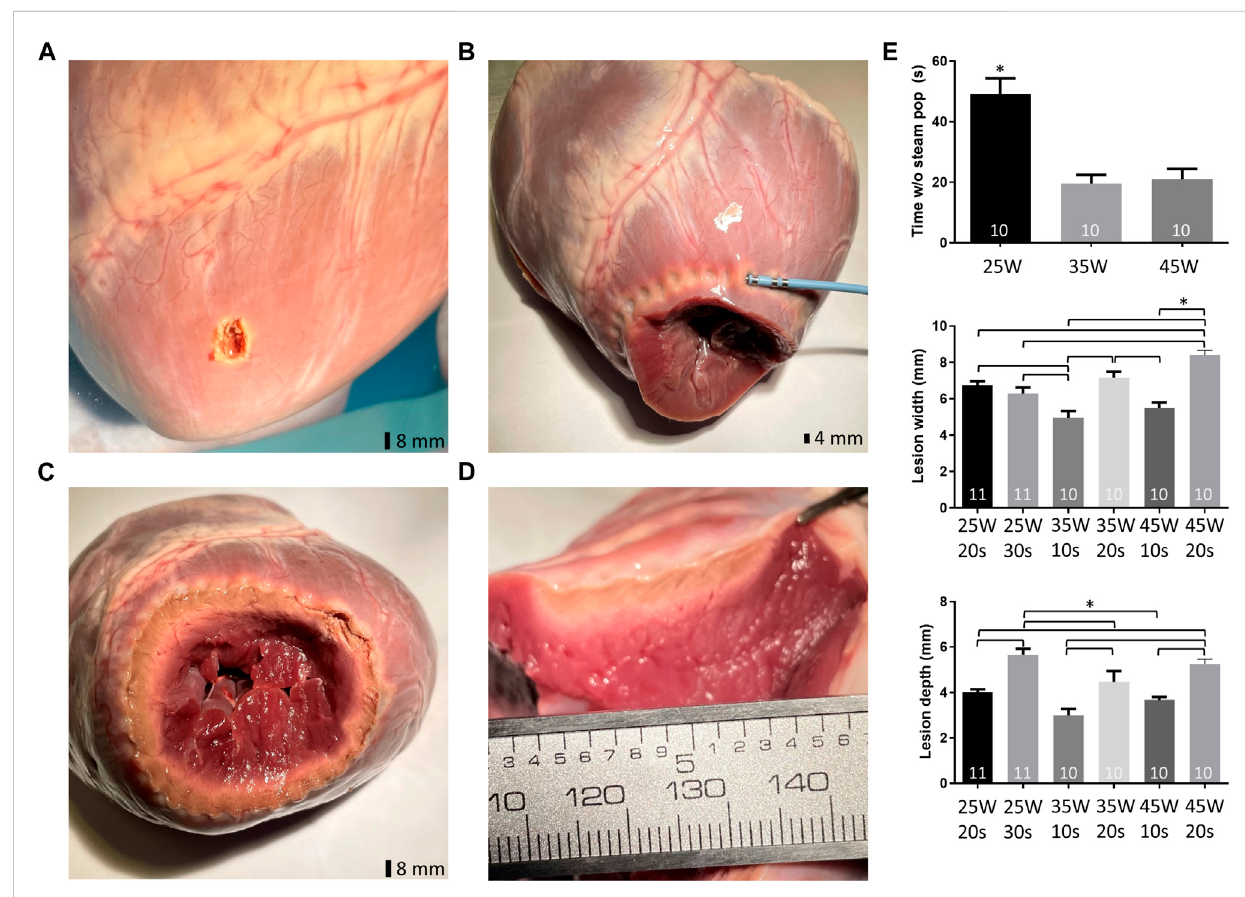
Lesion characteristics ex-vivo (pig). (A) . Example for “ steam pop ” related myocardial injury after epicardial ablation. (B) . Encirclement using RF- ablation (Celsius catheter ® ) of the prospective LVAD implantation site/cannulation site. (C) . Cross-section of the left ventricle with continuous set of RF lesions. (D) .ContinuityofRF-lesions(manualinter-lesiondistance5 mm). (E) .Timewithout “ steampop ” i.e.,safeablationtimewith25,35and45Wusing the Celsius 3.5 mm tip catheter at 43 ° C and 15 mL/min irrigation (top left). Lesion depth and widths using the RF settings as indicated (center,